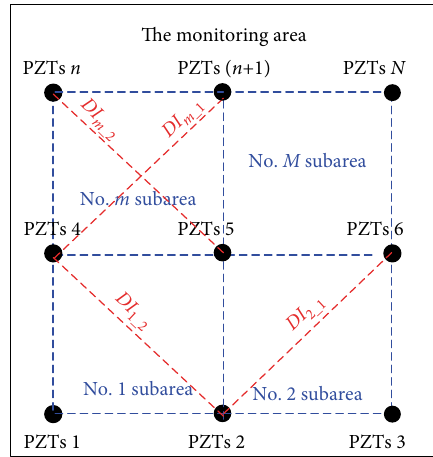
Figure 2: Diagram of damage region identification.